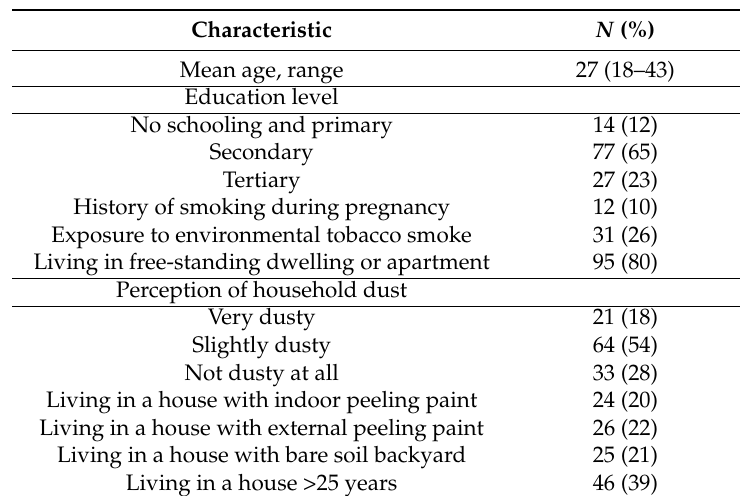
Table 1. Profile of study population ( n =